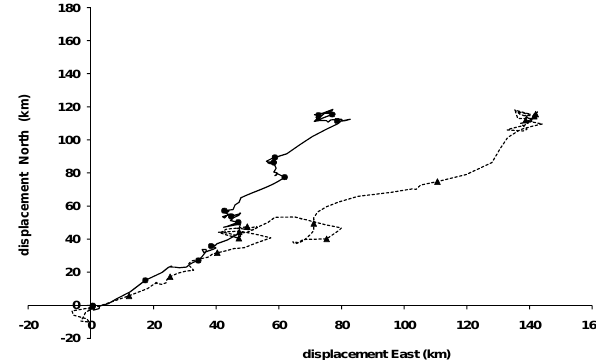
Fig. 6. Progressive vector diagram for North Dogger for May to September 2007. Solid line is 5m above seabed, dashed line is 66m above seabed. Markers identify every tenth day at each